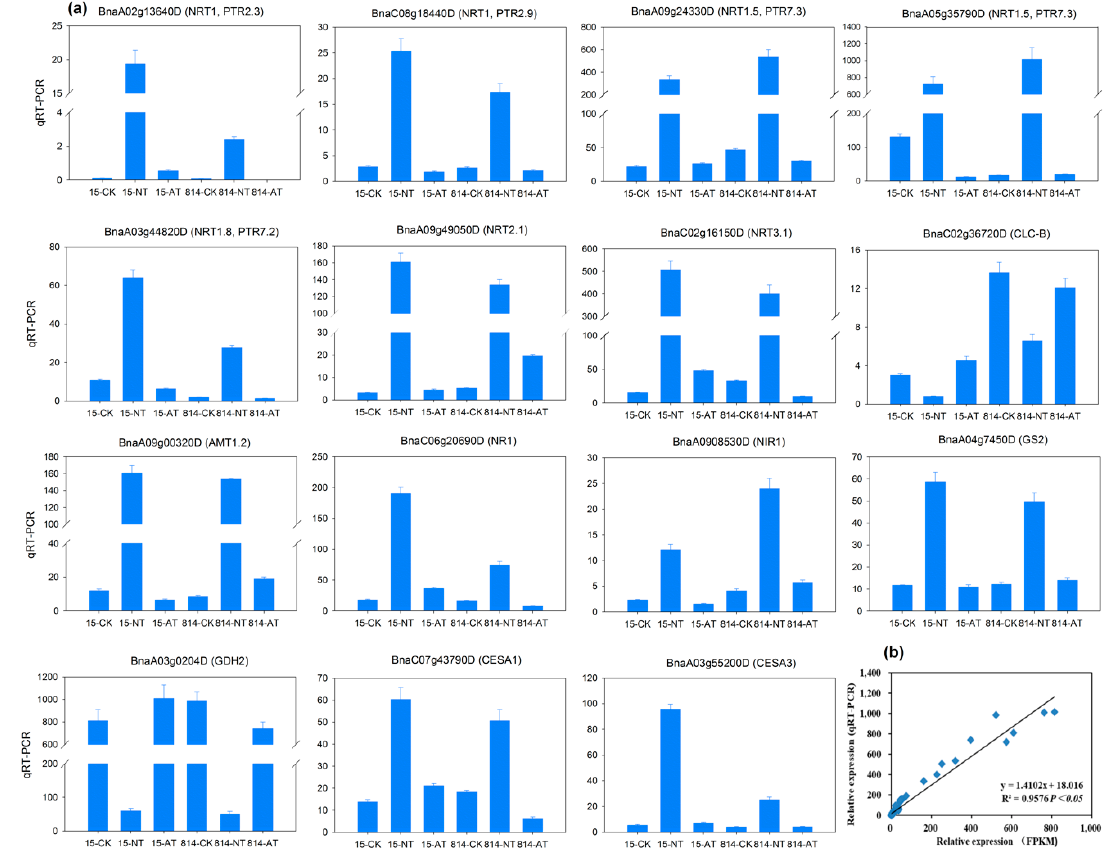
Figure 7. Quantitative real-time PCR (qRT-PCR) validation of 15 differentially expressed genes (DEGs). ( a ) Transcript levels of 15 DEGs. Vertical bars indicate SDs (n = 3). The columns represent relative expression obtained by qRT-PCR. ( b ) Comparison of relative expression obtained from RNA-Seq data and qRT-PCR. RNA-Seq relative expression ( x -axis) is plotted against qRT-PCR relative expression ( y -axis). The correlation coefficient (R 2 ) is indicated in the figure. FPKM: fragments per kilobase of exon per million fragments mapped.